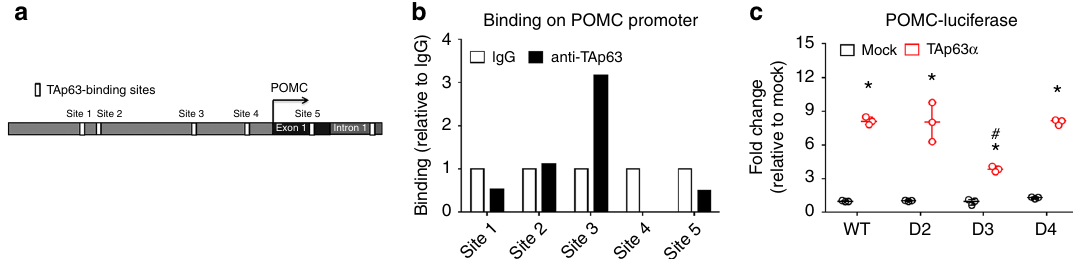
Fig. 2 TAp63 stimulates POMC gene expression. a Five potential TAp63-binding sites on mouse POMC gene promoter. Site 1: − 2011 to − 1989; site 2: − 1840 to − 1818; site 3: − 884 to − 862; site 4: − 155 to − 135; site 5: 436 – 458, relative to the transcriptional start site. b CHIP assay using TAp63 antibody (or IgG as negative controls) to pull down the TAp63-binding sites from mouse hypothalamus. c Effects of TAp63 α on POMC-luciferase activity in N46 cells. WT, pGL3b-POMC promoter; D2-4, pGL3b-POMC promoter with the deletion of sites 2, 3, or 4. Data are presented as box and wiskers showing minimal, maximal, and median values with individual data points. N = 3. * P < 0.05 vs. mock in the same POMC promoter; # P < 0.05 vs. WT POMC promoter in response to the same TAp63 overexpression in two-way ANOVA analysis followed by post hoc Sidak